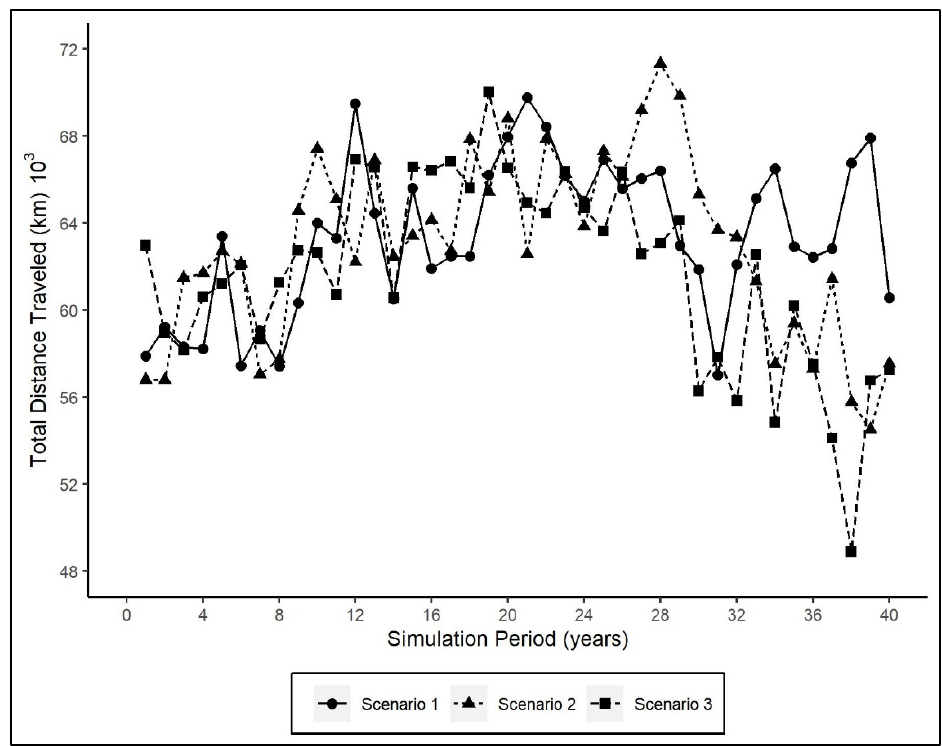
Figure 9. Distribution of total distance traveled for sourcing pulpwood over the simulation period. Scenarios 1, 2 and 3 are differentiated in Table 1.